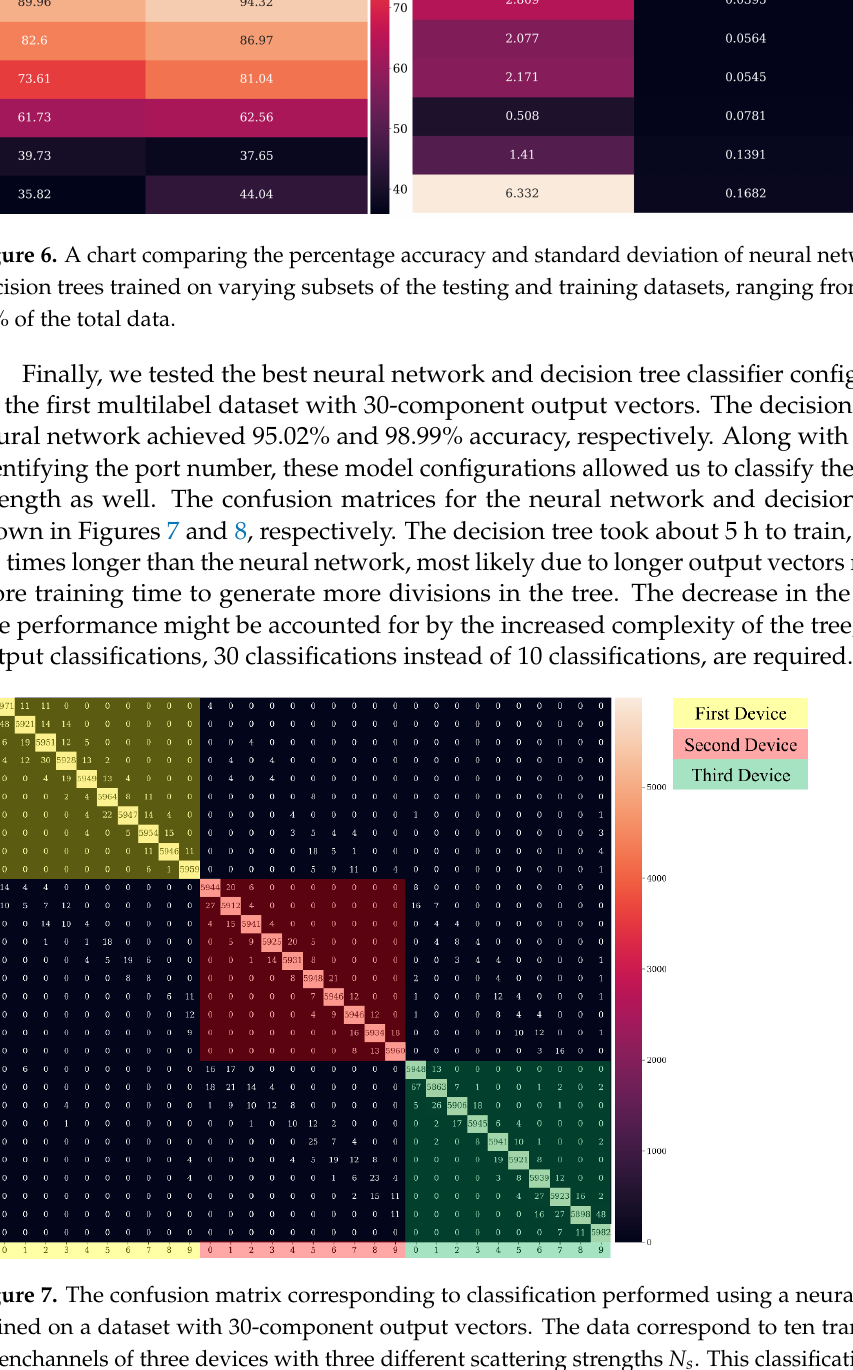
Figure 8. The confusion matrix corresponding to classification performed using a decision tree trained on a dataset with 30-component output vectors. The data correspond to ten transmission eigenchannels of three devices with three different scattering strengths N s . This classification allows for identification of both the eigenchannel as well as the disorder strength. The ports corresponding to the respective three devices are color coded. The maximum value in any cell can be 6000.